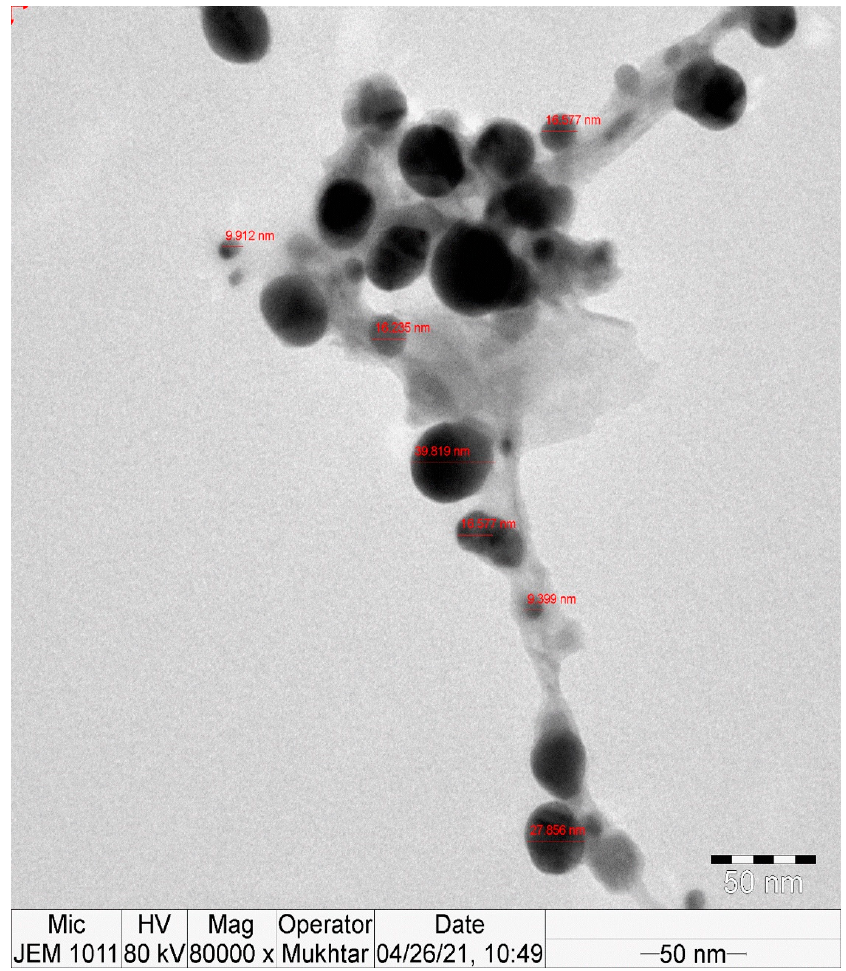
Figure 4. TEM micrographs of the biosynthesized AgNPs .